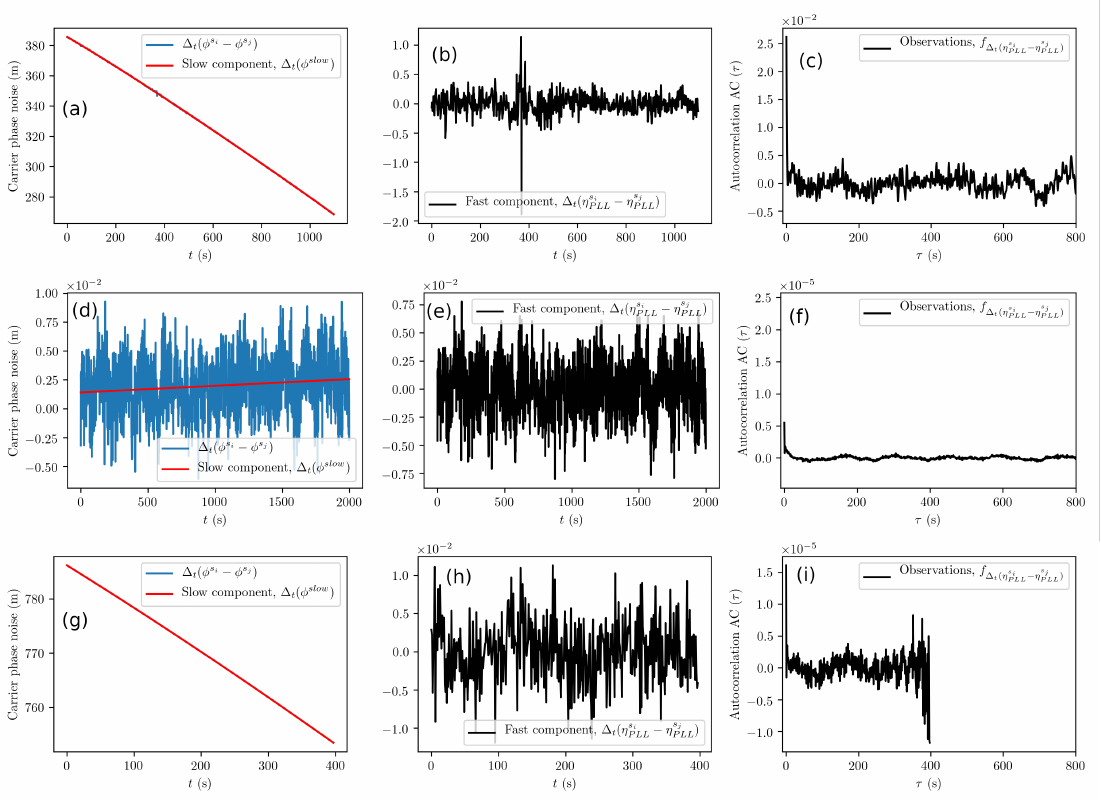
Figure 6. Carrier phase noise analysis (Phase Lock Loop (PLL)) from GPS L1C data for Samsung S8 ( a – c ), u-blox with the patch antenna ( d – f ), and Septentrio ( g – i ) receivers. ( a , d , g ) Raw data with a red line showing the slow component trend. ( b , e , h ) PLL fast component. In ( e ), variation is within ± 7.5 mm. ( c , f , i ) Autocorrelation function calculated from the respective fast component. Note the anomaly in ( b ), most likely due to a loop slip. Furthermore, we selected a short times series in ( g ); see the impact on ( i ).